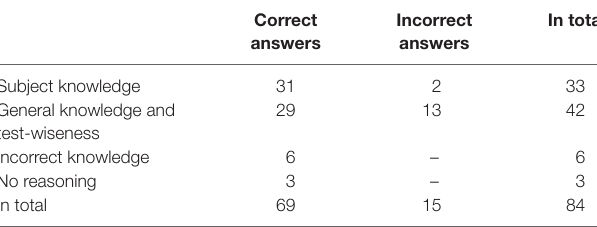
Table 3 | Overview of students’ strategies in answering the multiple-choice- equivalent items.